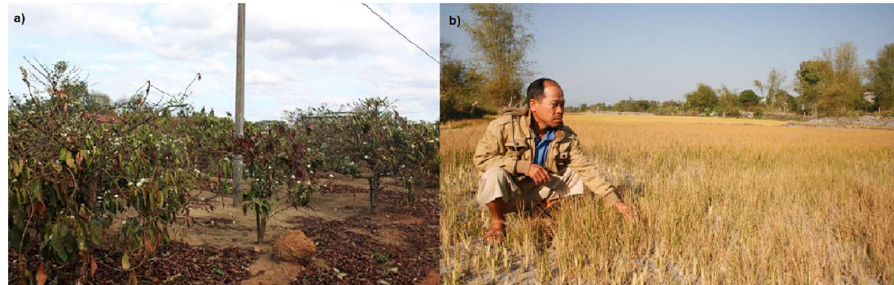
Figure 10. Images of agricultural products damaged by the drought in March 2016: ( a ) Coffee trees in a farm in the Ia Grai district, Gia Lai Province were shriveled up, due to a lack of irrigation during the drought [46]; and ( b ) a farmer in Gia Lai Province on his rice farm with yield losses [47].